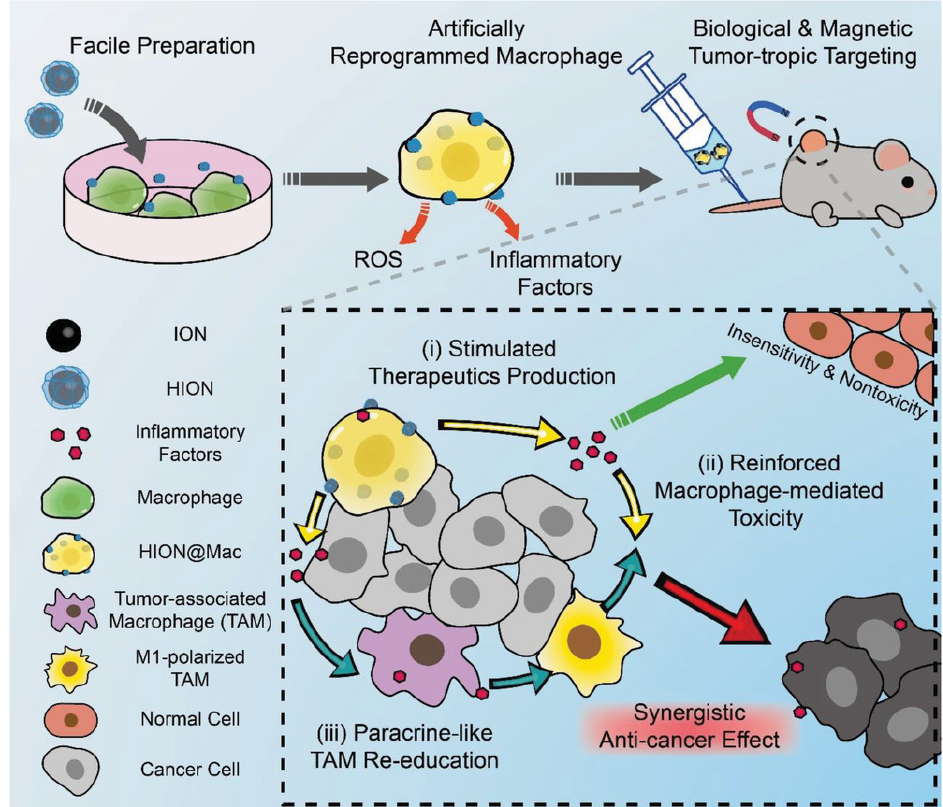
Figure 10. Schematic illustration depicting that the artificially reprogrammed HION@Macs target tumors through active chemotaxis and magnet guidance, produce inflammatory factors (such as TNF- α , NO and ROS) to suppress tumor, re-educate in situ M2 macrophages into pro-inflammatory M1 phenotype for synergistic cancer-specific therapy. Reprinted with permission from Ref. [51]. Copyright 2019 John Willey and Sons.